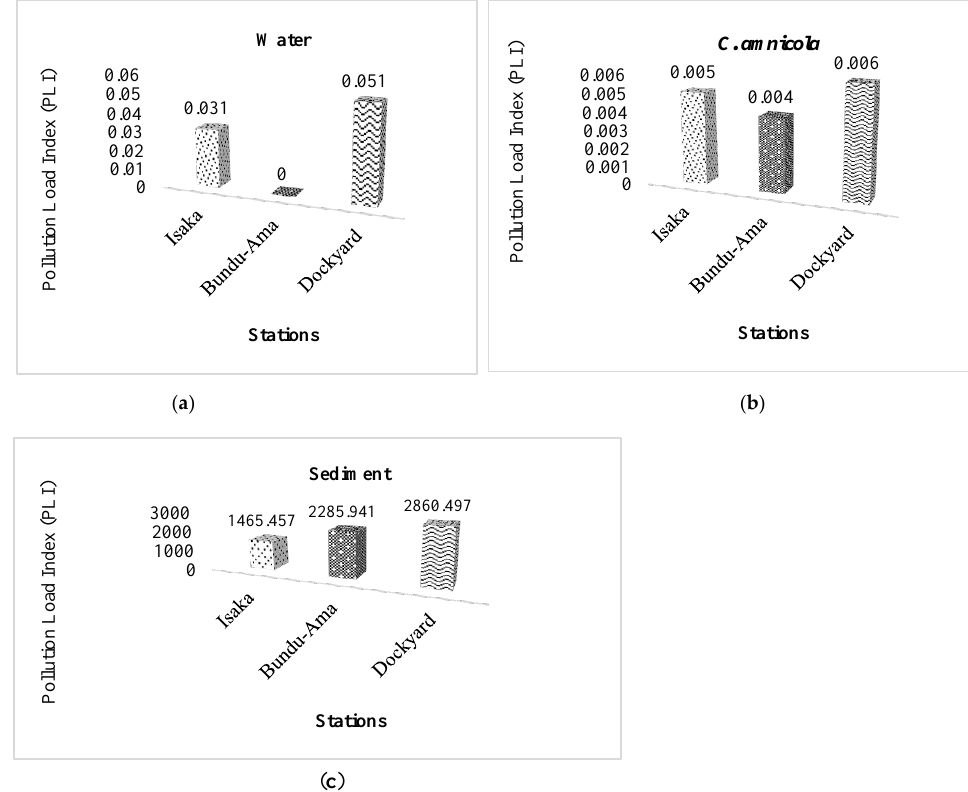
Figure 3. The pollution load index (PLI) in Isaka–Bundu tidal mangrove swamp. ( a ) The pollution load index (PLI) values for water; ( b ) The pollution load index (PLI) values for C. amnicola; ( c ) The pollution load index (PLI) values for sediment.